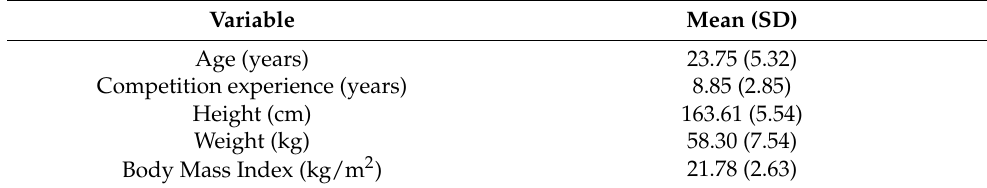
Table 1. Descriptive data of